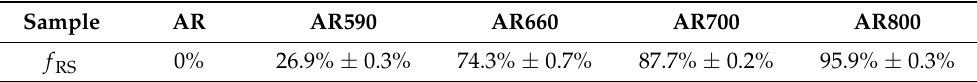
Table 4. Mean area fraction of recrystallized regions in various